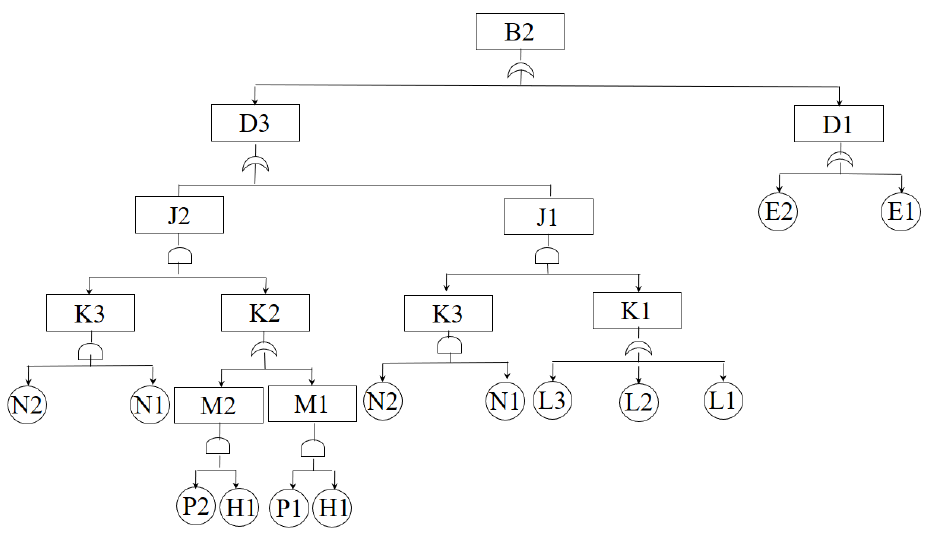
Figure 7. Fault tree of ship-to-ship collisions.